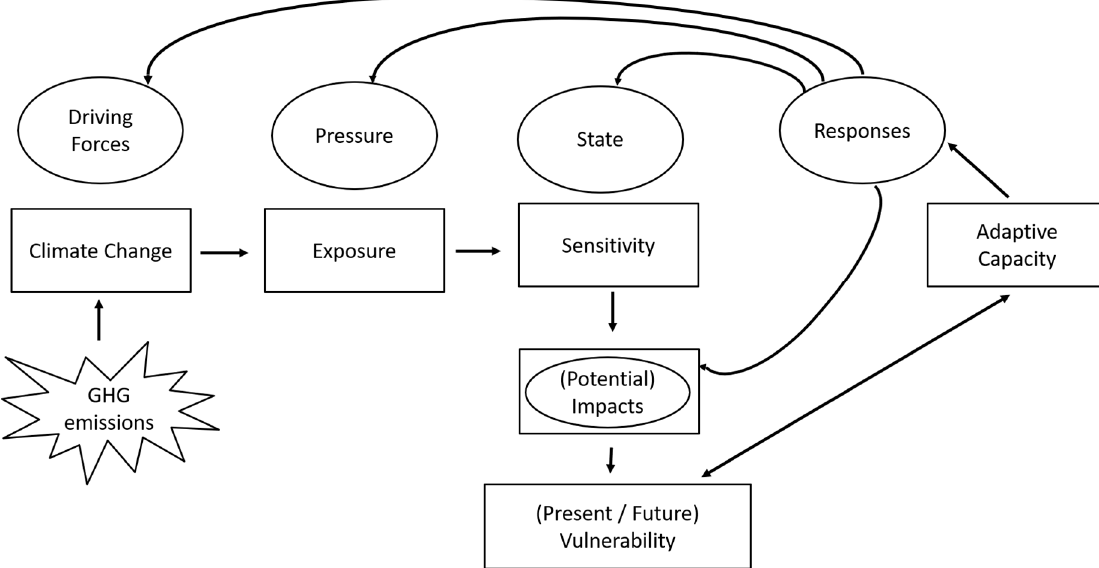
Figure 2. Combination of Vulnerability and DPSIR Framework. Items in rectangles refer to the Vulnerability Framework and items in circles refer to DPSIR Framework. Arrows indicate causal relations. GHG emissions are one of the main causes for Radiative Forcing and increase in Climate Change which is felt depending on the level of Exposure. Depending on the Sensitivity, this Exposure leads to Potential Impacts and Vulnerability, which is dependent on the Adaptive Capacity. Adaptive capacity can generate Responses that can be targeted at the origin of the problem, the Driving Forces and the Exposure/Pressure factors. Responses can improve the State of the ecosystem to make it less sensitive, or finally target the consequences, the Impacts on the system.